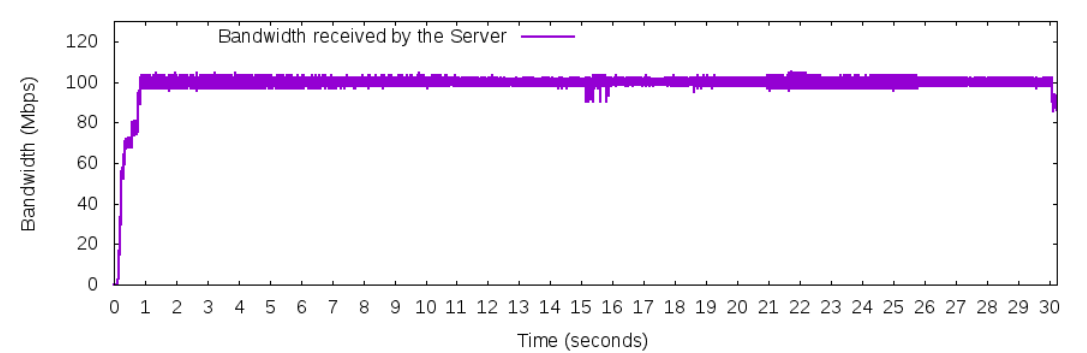
Figure 10. The average of multiple measurements for the network traffic during a link failure around the 15th second with a confidence interval of 95%.